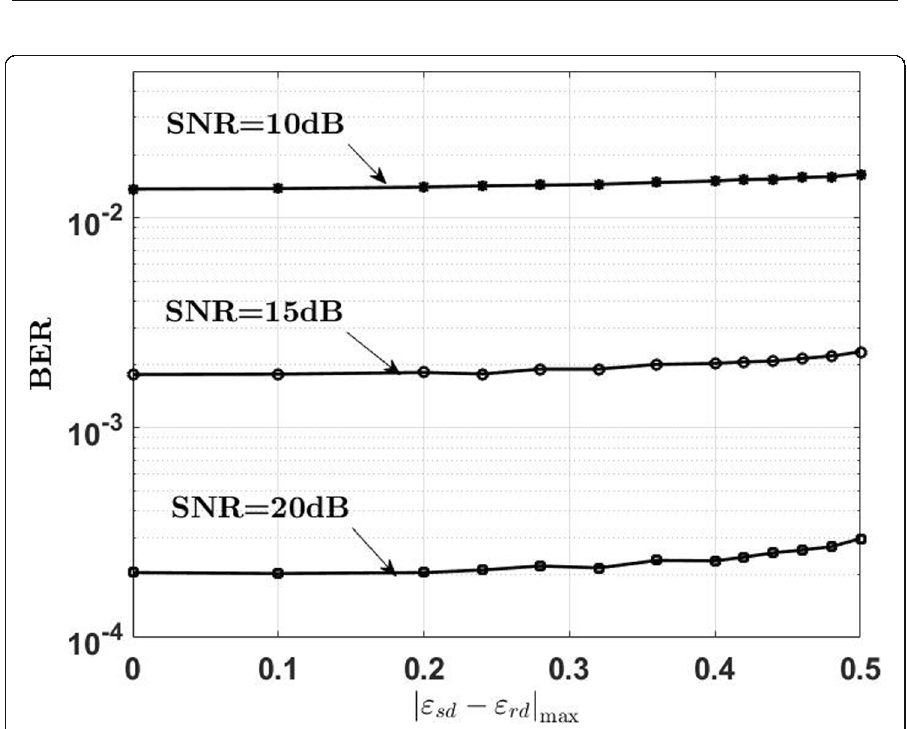
Fig. 8 Effect of | ε sd − ε rd | max on the BER performance. Figure 8 shows the effect of | ε sd − ε rd | max on the BER performance of proposed algorithm in collaborative communication systems when PB channel was